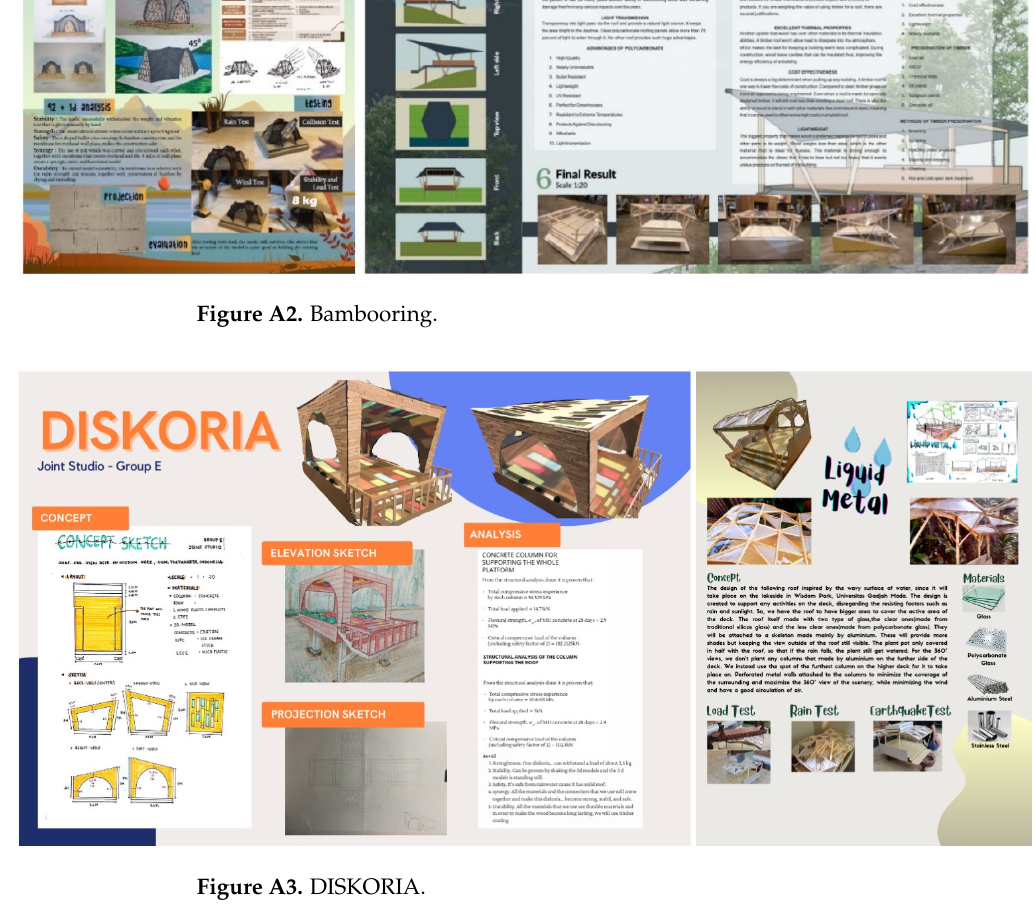
Figure A3. DISKORIA.